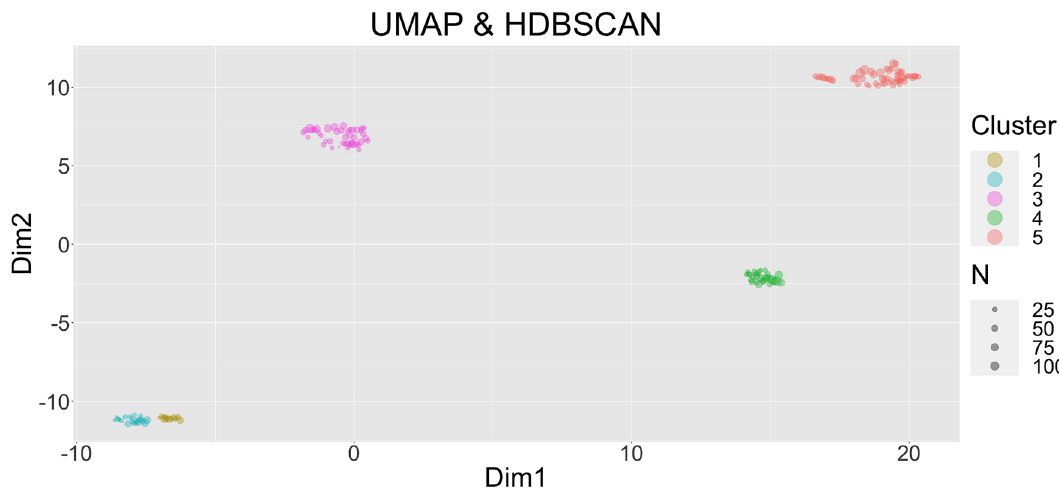
Figure 1. UMAP-HDBSCAN clustering. Each circle corresponds to a farm and the size of the circle is proportional to number of cows on a farm. Five clusters of farms can be identified, which are represented by different